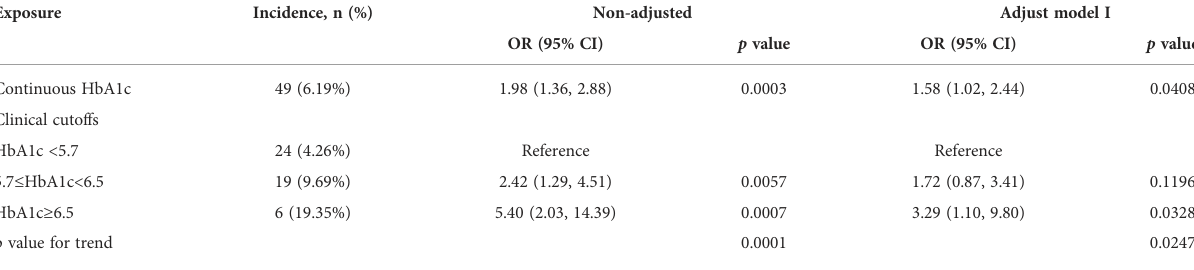
TABLE 2 Individual effect of HbA1c on cervical